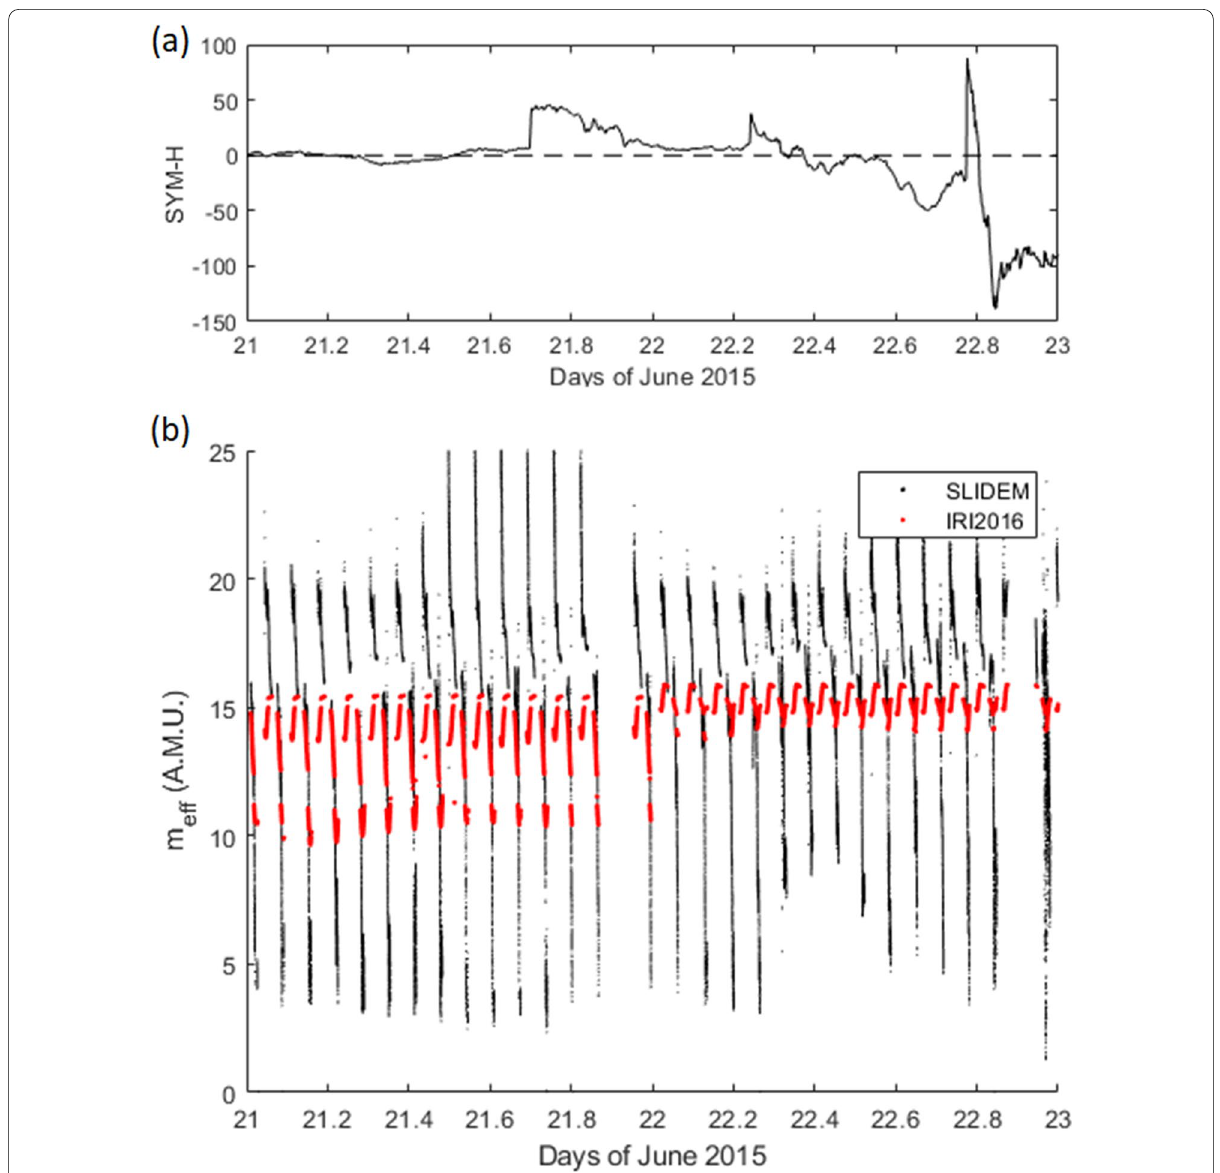
Fig. 6 Plot of the SYM-H a as well as Swarm A IRI-2016 and SLIDEM M eff estimates for the time around the 22 June 2015 storm, denoting the change in effective ion mass during this active time period. In this plot, M eff estimates outside of the validity range of this parameter (i.e., at high latitudes) are omitted both for SLIDEM and for